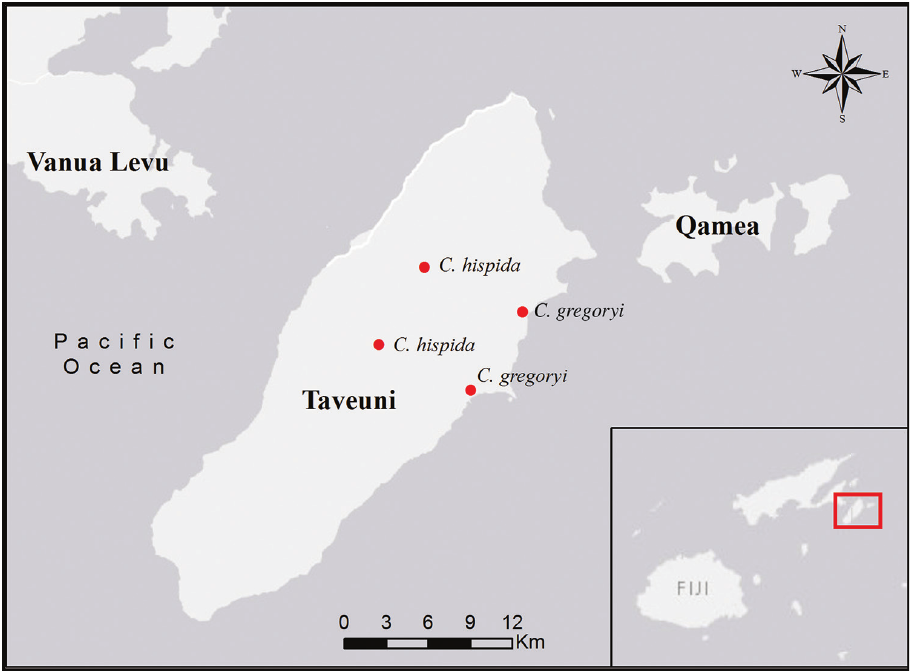
Figure 3. Distribution of Cyrtandra gregoryi and C. hispida on Taveuni, Fiji. elevation. These species share a cymose inflorescence and glabrous to glabrate leaves. The key provided in the taxonomic treatment by Gillett (1967) would place C. gregoryi in species Group 5 based on the branching cyme inflorescence, non-woody inflorescence axis, deciduous calyx, styles and/or stamens being exserted from the corolla tube, and stamens 8–12 mm